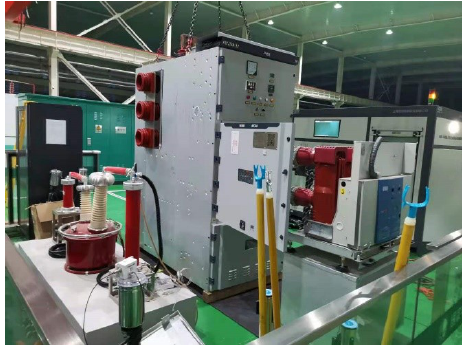
Fig. 15. Physical experiment